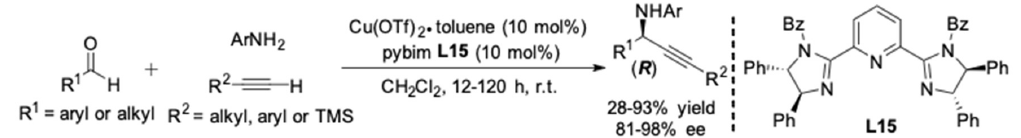
Figure 8. Cu(II)/pybim-catalyzed AA 3 -couplings.